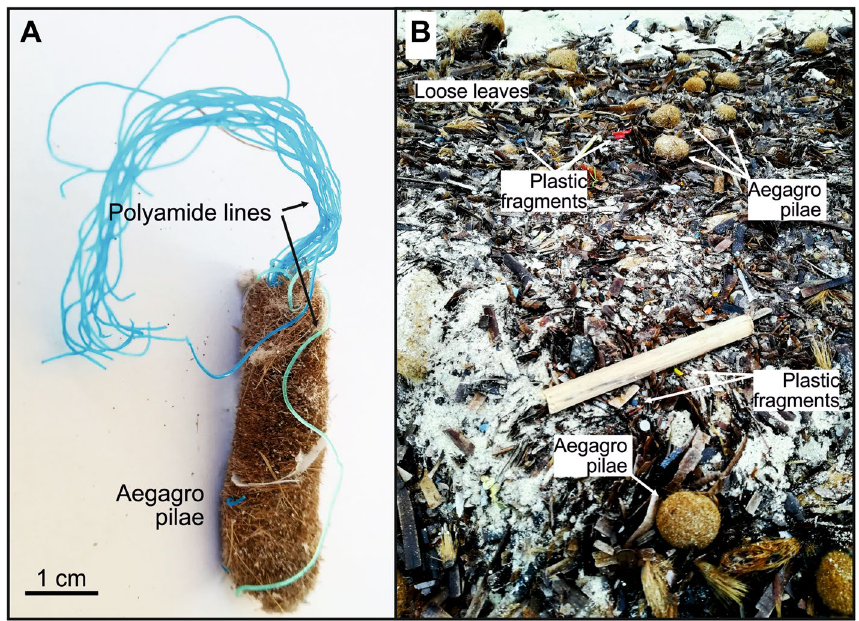
Figure 3. Plastic debris in aegagropilae (EG) and loose leaves found in beaches. ( A ) Polyamide filaments trapped in aegagropilae (EG), and ( B ) beached EG and loose leaves along with plastic